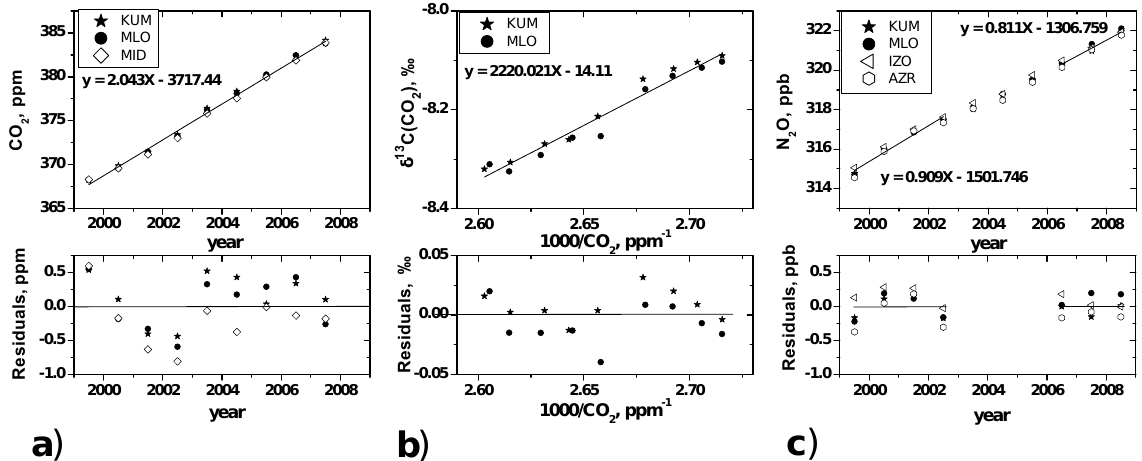
Fig. 3. Linear fits through annual means of CO 2 (a) , δ 13 C(CO 2 ) (b) and N 2 O (c) for selected background NOAA stations (see Table 2). Residuals are shown in lowermost panels. To demonstrate the consistency between the δ 13 C(CO 2 ) increase rate with the CO 2 increase, the δ 13 C(CO 2 ) trend vs. 1/CO 2 has been used, see text. Table 2. Annual increase rates (linear fits) for the NOAA